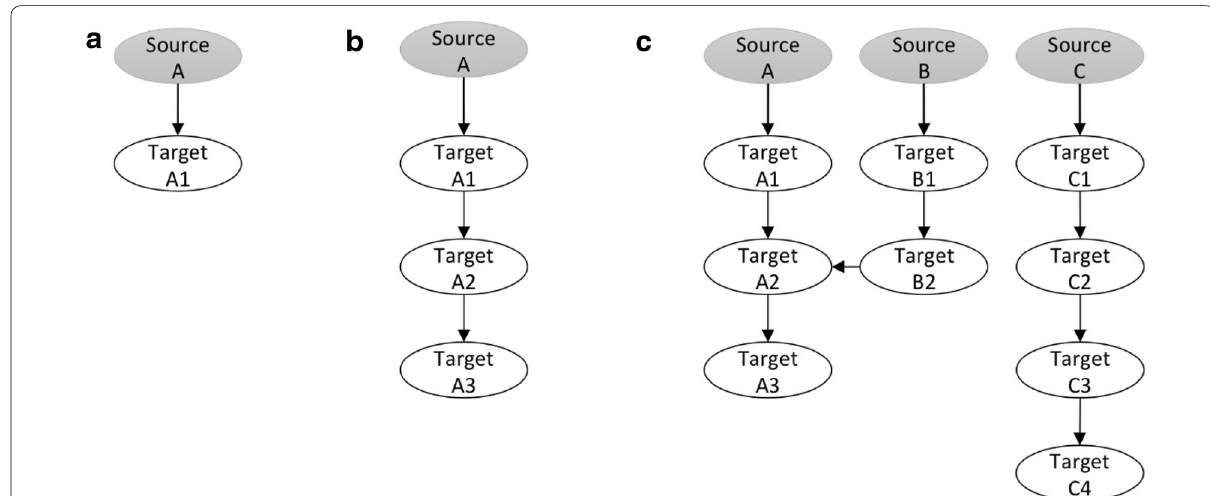
Fig. 1 Diagram of gene regulatory network inference workflow. a Identification of a significantly associated gene pair. b Regulation path elongation. c Assembly of all identified regulation